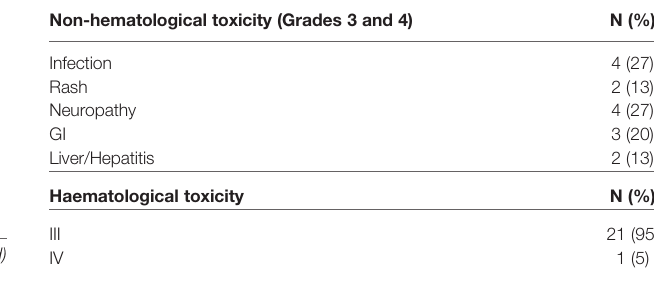
TABLE 2 | Treatment related adverse